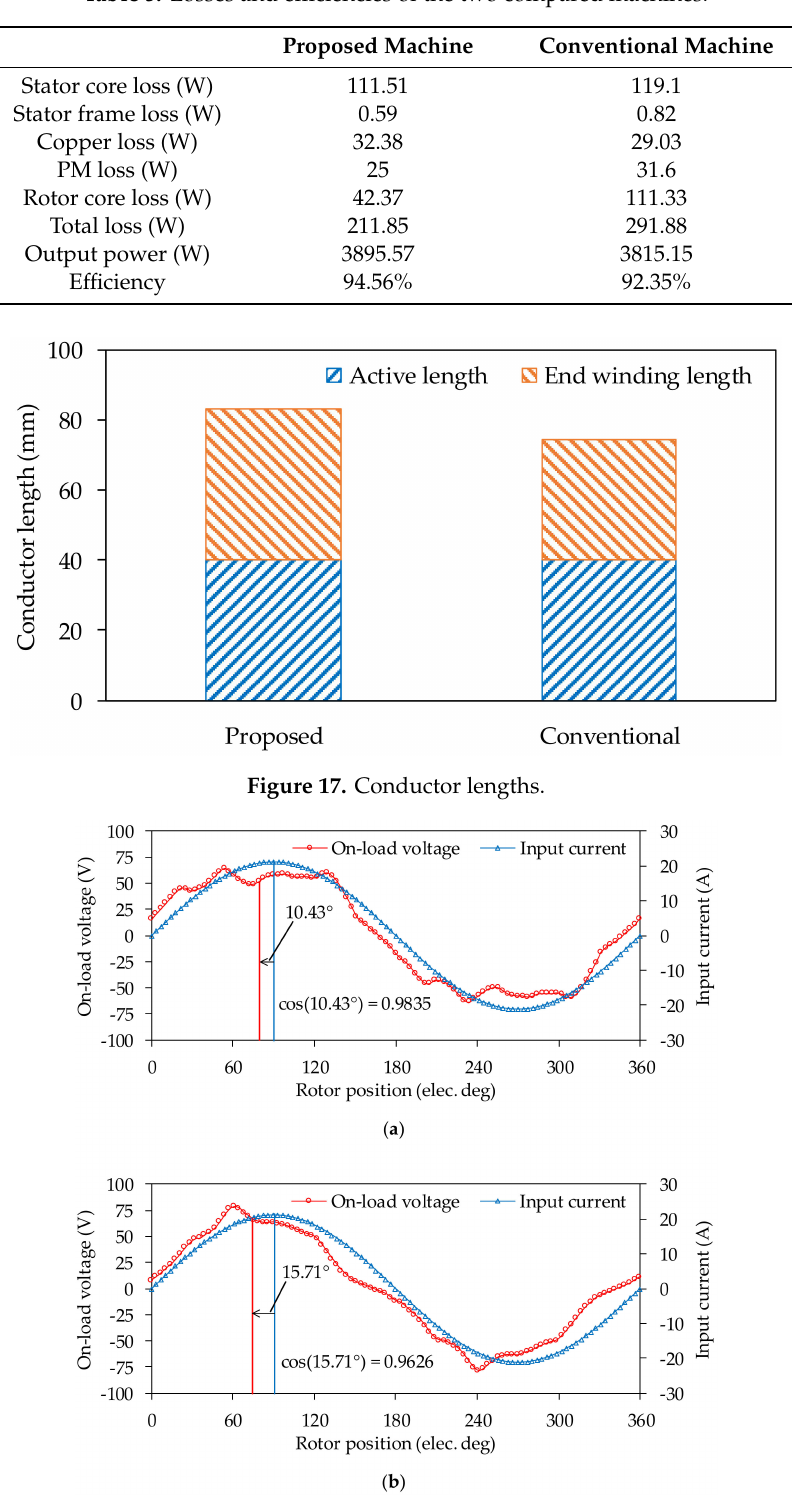
Figure 18. On-load voltage and input current waves: ( a ) proposed machine, ( b ) conventional